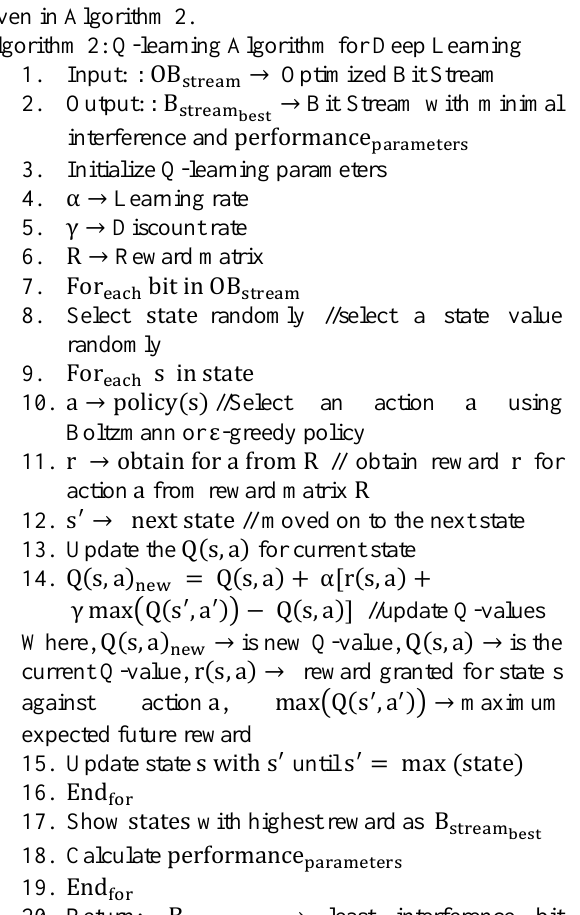
Algorithm 2: Q-learning Algorithm for Deep Learning